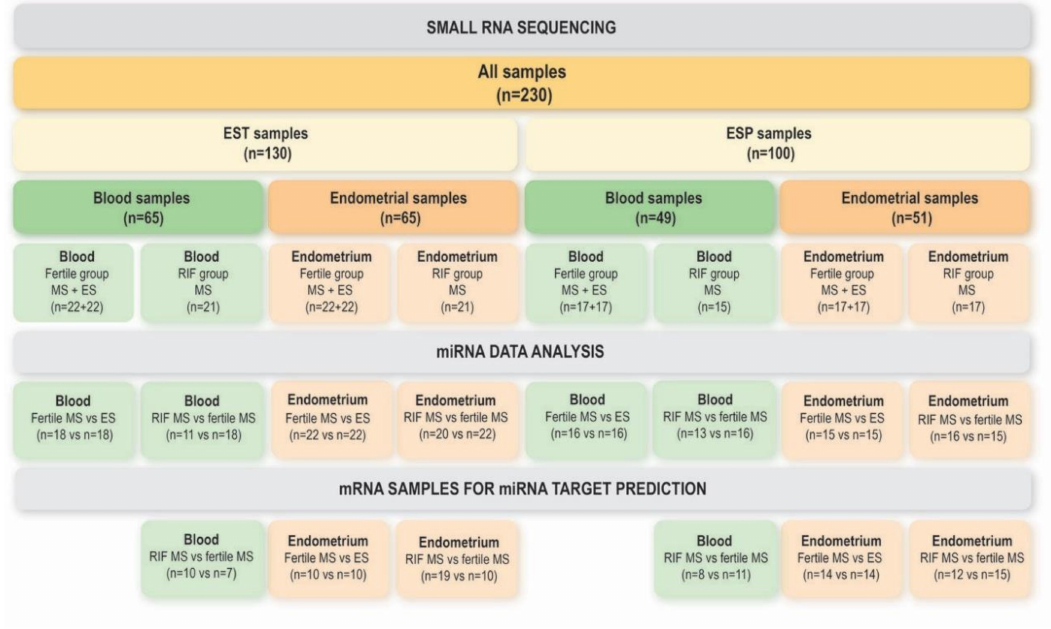
Figure 1. Number of samples included to small RNA sequencing, to final microRNA (miRNA) analysis and to messenger RNA (mRNA) sequencing analysis. EST—Estonian samples; ESP—Spanish